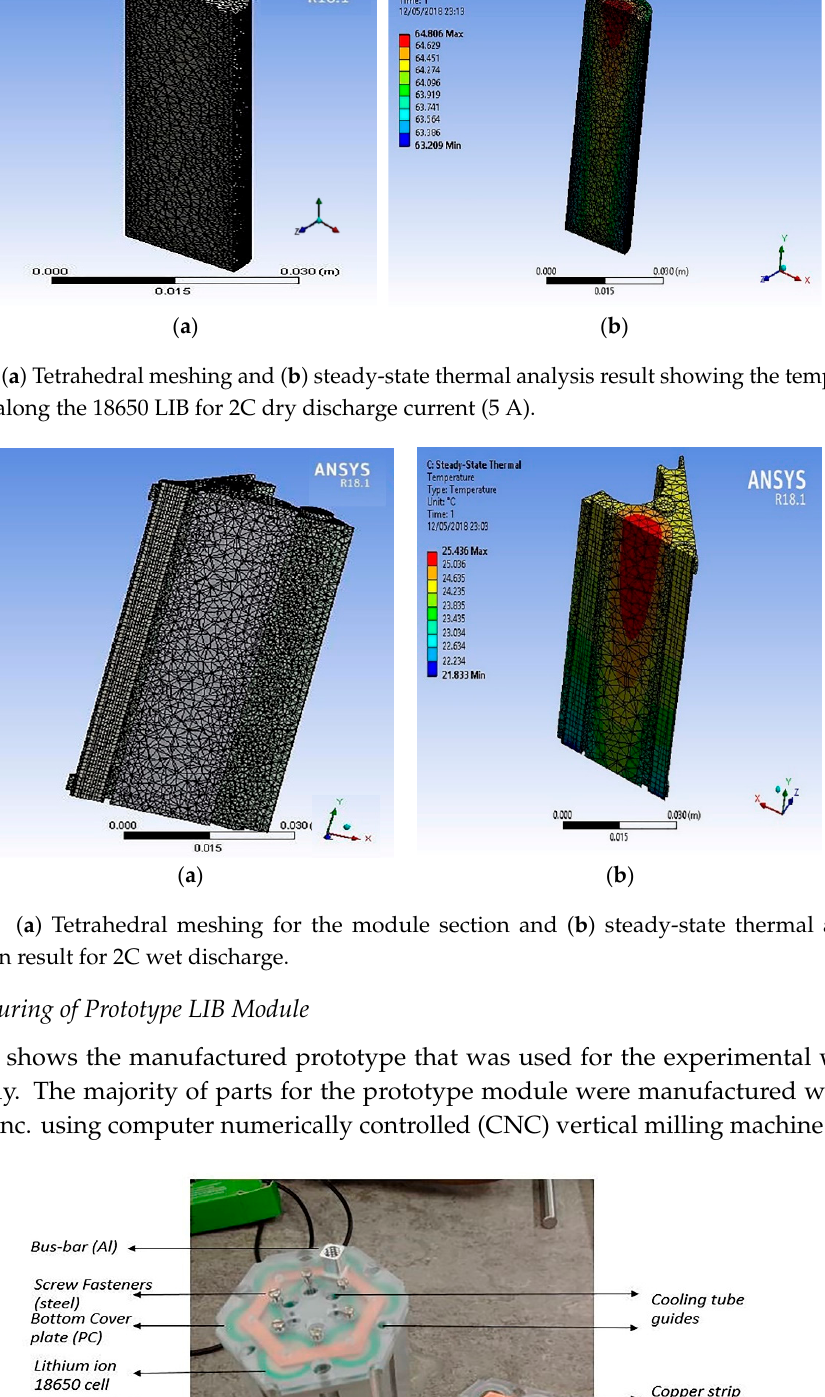
Figure 7. Battery module prototype used for experimental work.